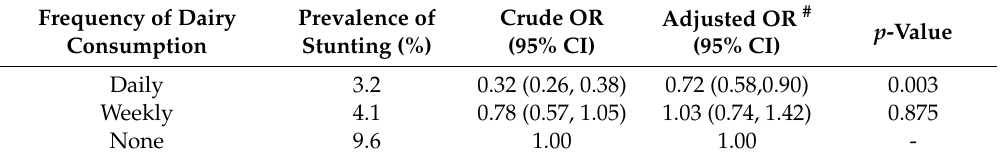
Table 4. Association between the prevalence of stunting and the frequency of dairy